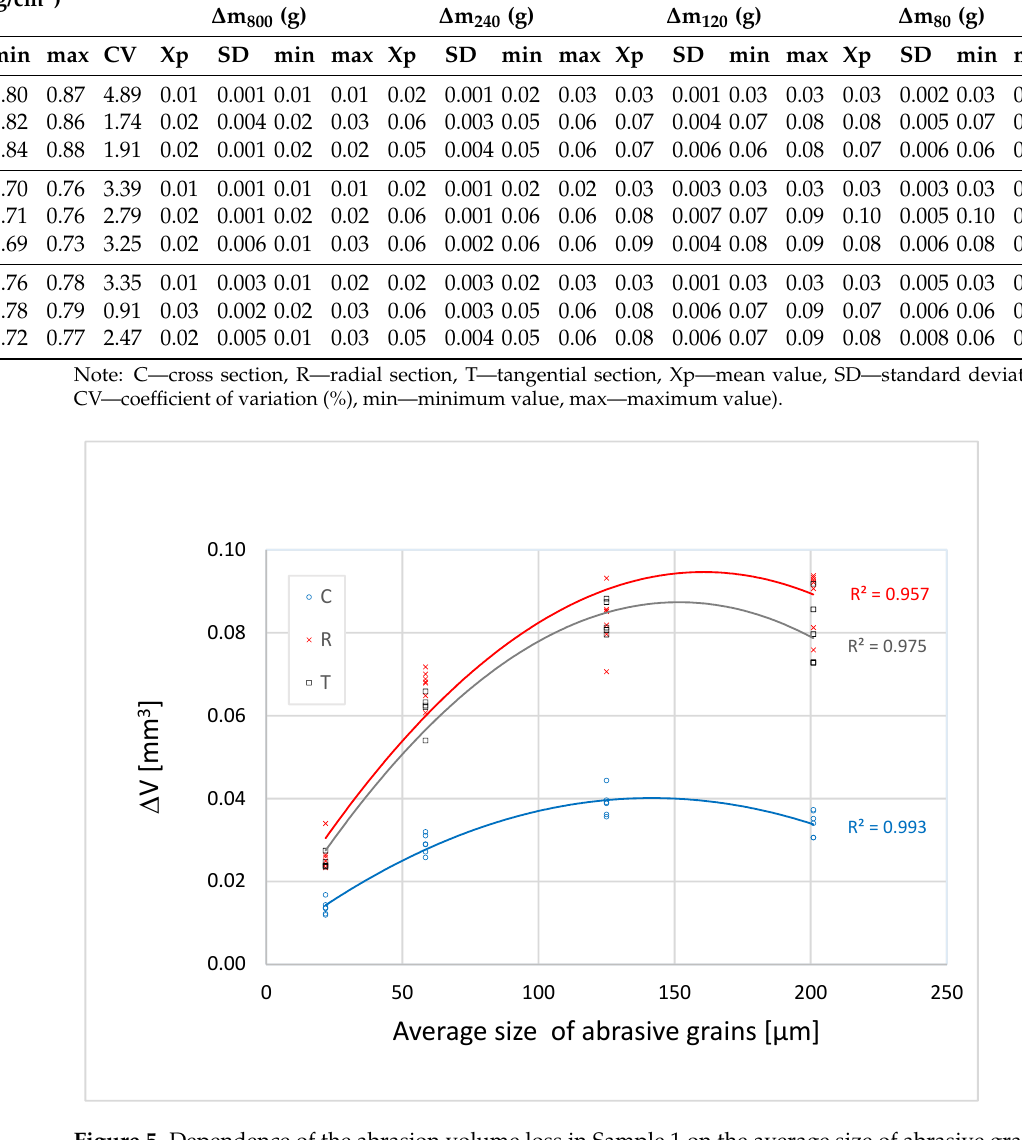
Figure 5. Dependence of the abrasion volume loss in Sample 1 on the average size of abrasive grains.